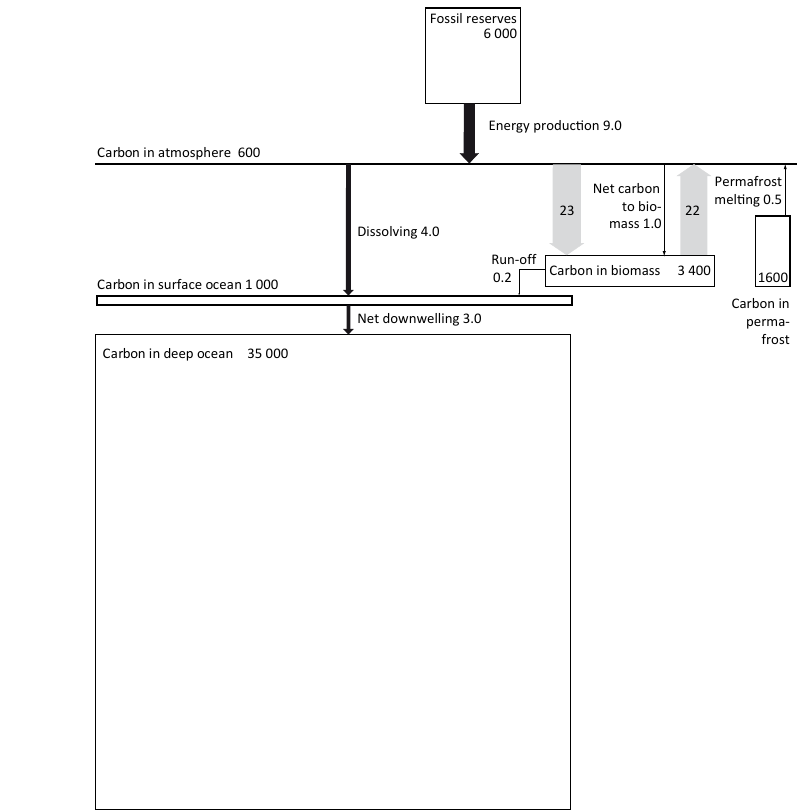
Figure 3. Stocks (in GtC) and flows (in GtCyr − 1 ) in the carbon sector of ESCIMO. World around the year